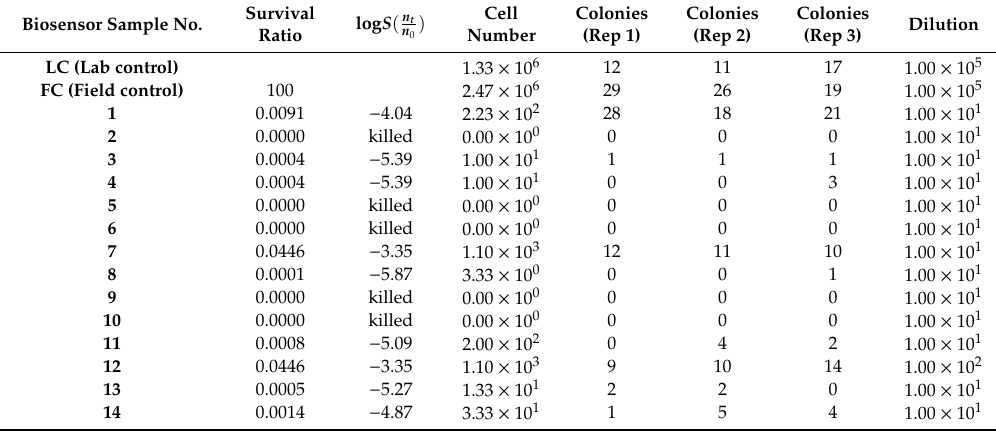
Table 5. Survivability ratio of Klebsiella oxytoca biosensors after treatment. Biosensor Sample